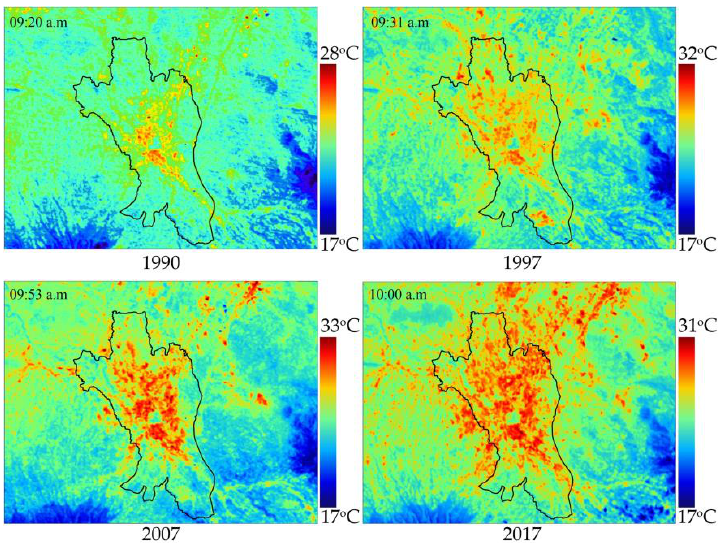
Figure 7. LST distribution maps.